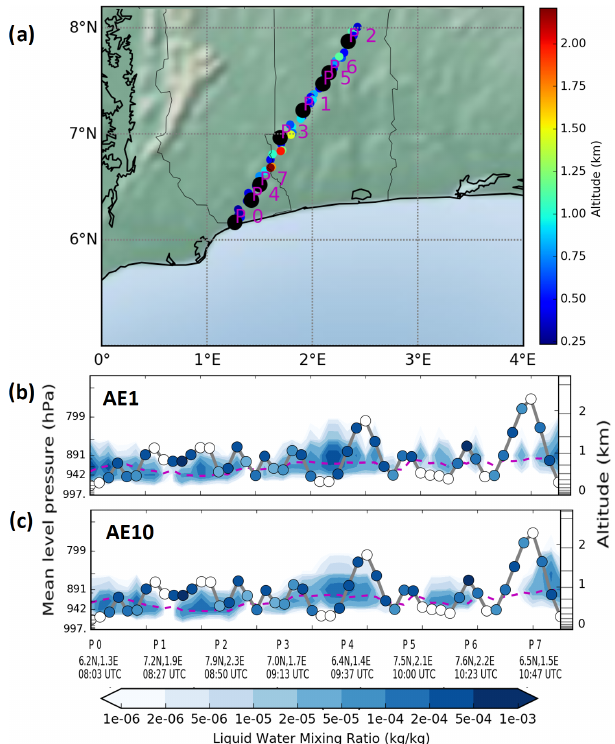
Figure 5. Vertical cross section of the liquid water mixing ratio (in kgkg − 1 ) along the trajectory of the ATR-42 research aircraft on 5 July 2016 denoted on the map (a) . The 3min averaged observa- tions are displayed by the colored circles and the modeled vertical distribution along the flight positions by the colored fields for the two experiments: (b) AE1 and (c) AE10, with modeled planetary boundary layer height (dashed violet